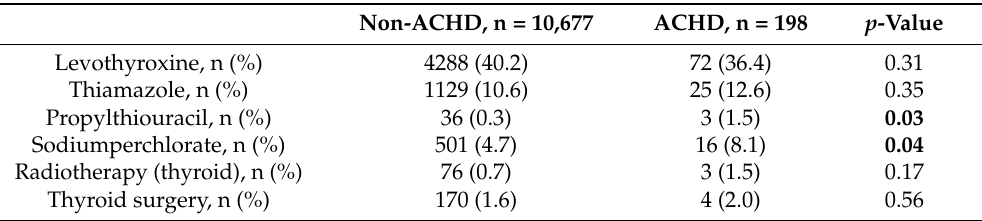
Table 4. Overview of treatment methods after diagnosis of thyroid dysfunction stratified by presence and absence of congenital heart disease (ACHD = adult congenital heart